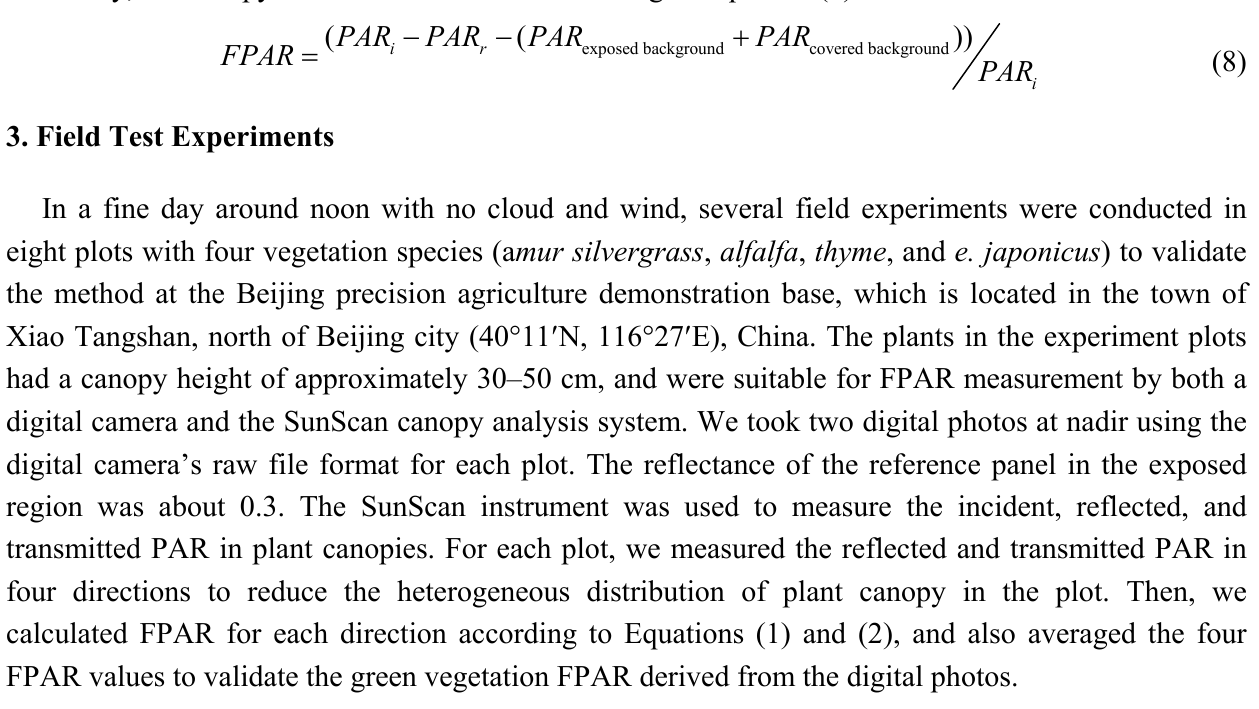
Figure 3. Relation between FPAR derived from the digital camera and the SunScan